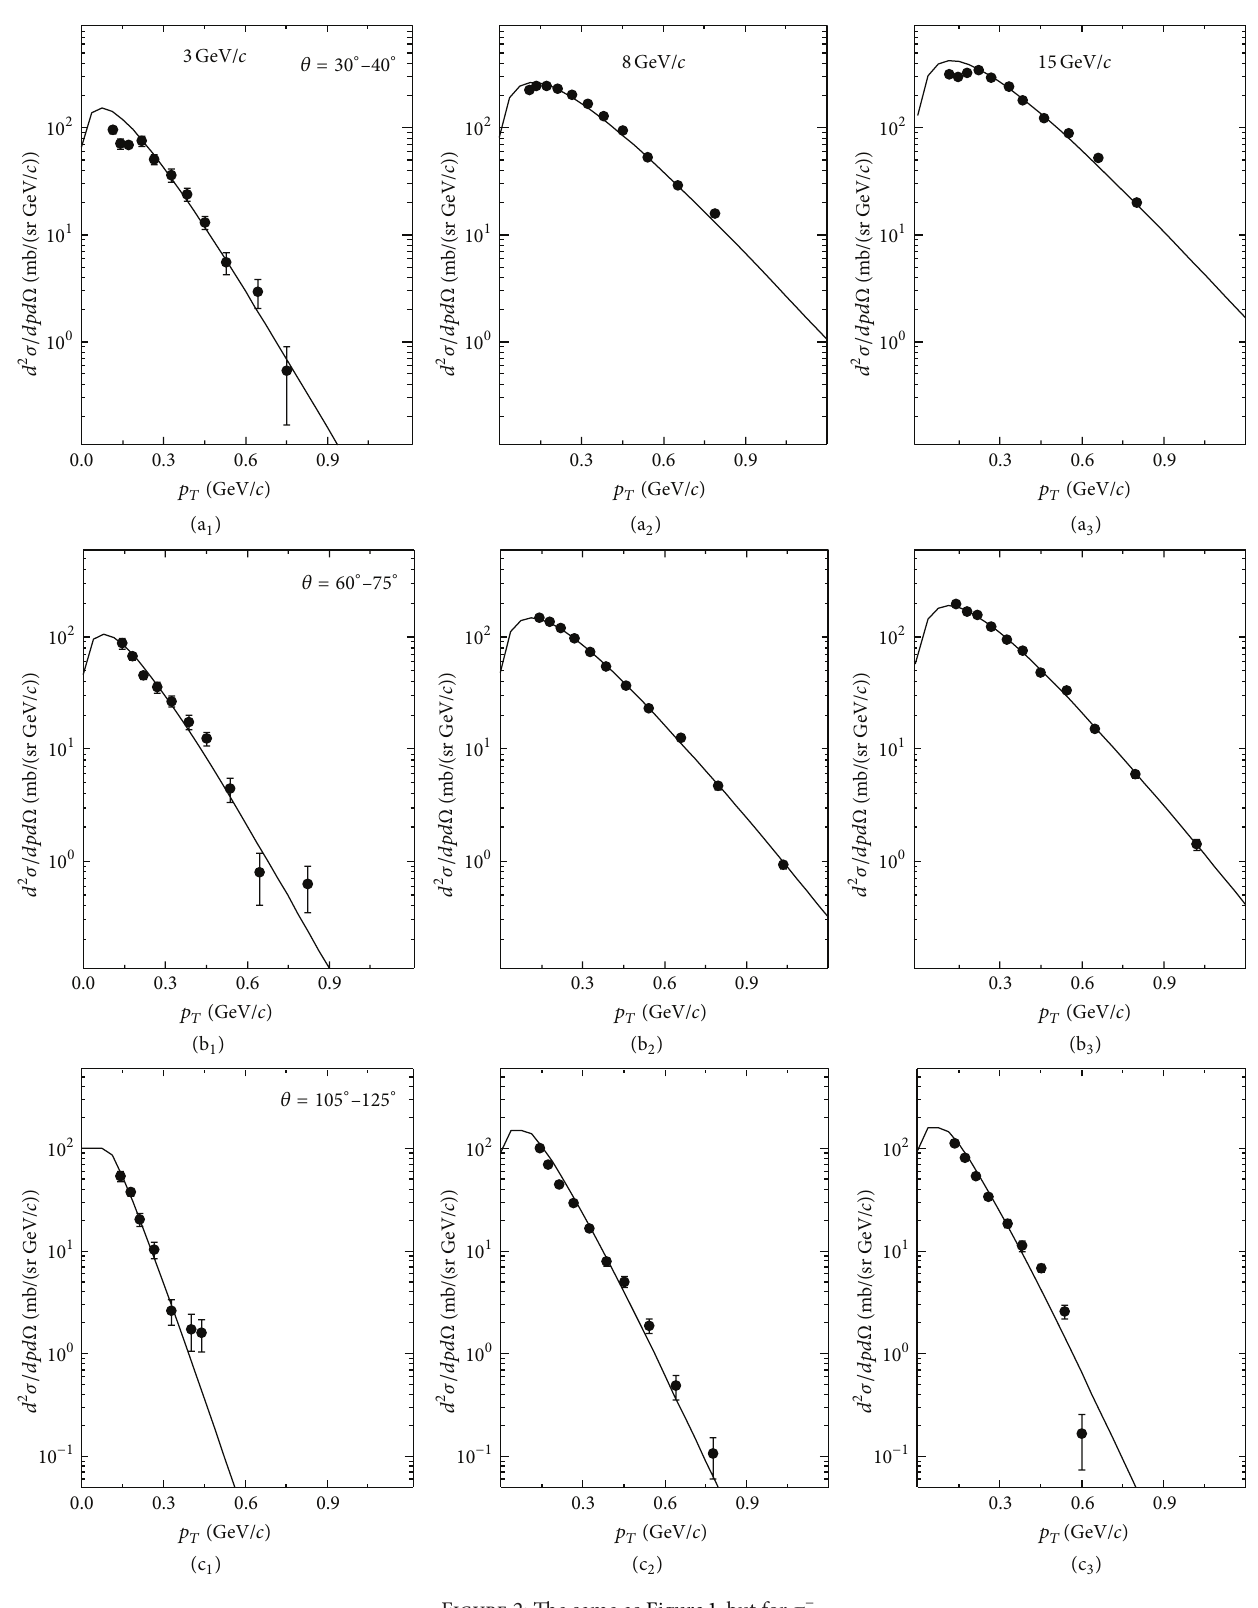
Figure 2: The same as Figure 1, but for 𝜋 −